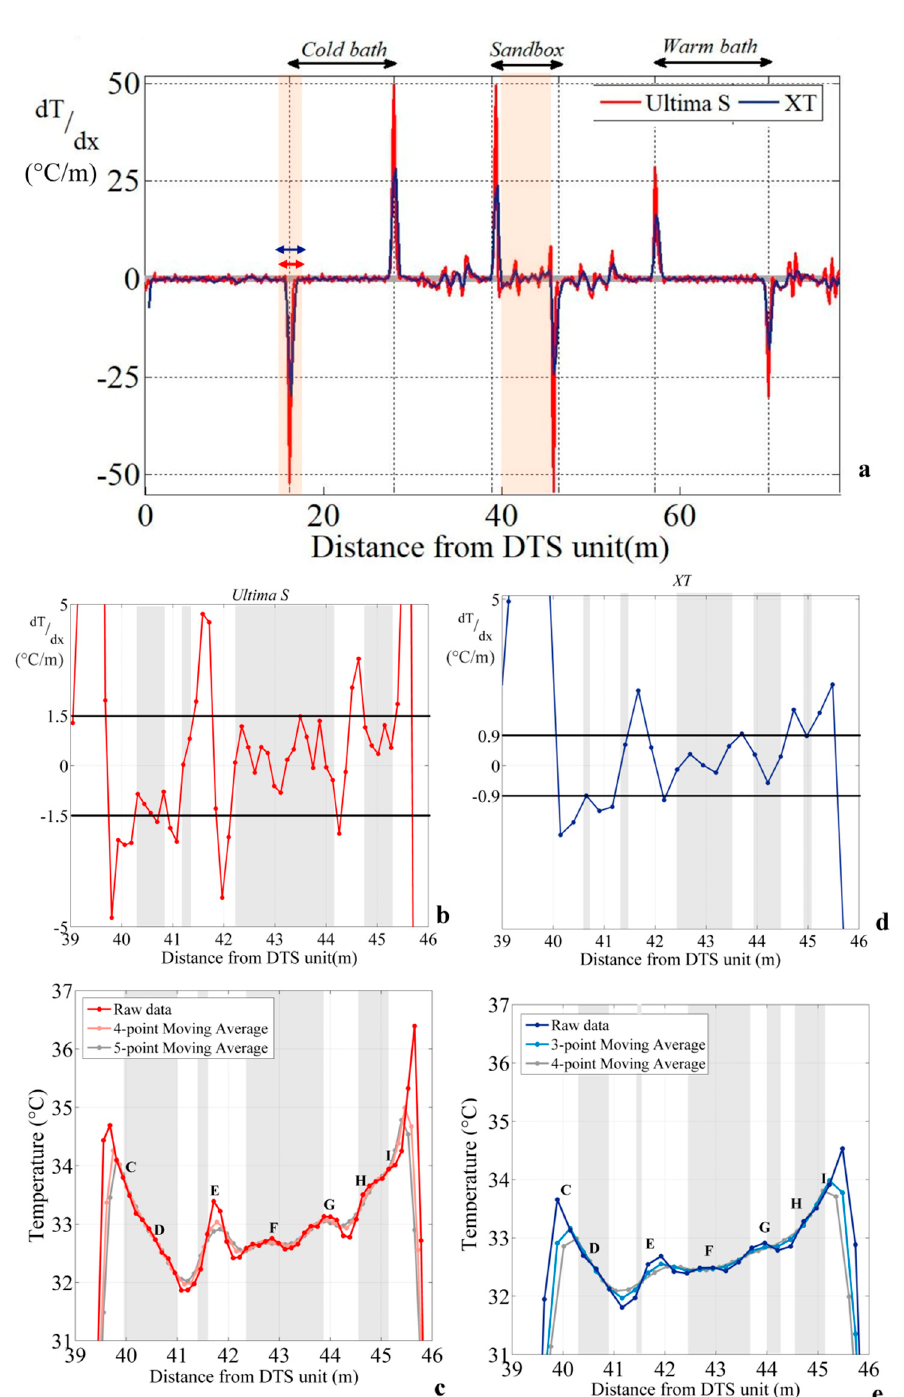
Figure 7. ( a ) Derivative of the temperature with respect to distance. Data were collected during the first heating period, at 02:02:14 p.m. for the Ultima S DTS (Distributed Temperature Sensing) unit and at 02:02:01 p.m. for the XT DTS unit. ( b ) Focus on the derivative of the temperature with respect to distance calculated in the sandbox for the Ultima S DTS unit. Horizontal grey bands represent significant measurement sections defined when the derivative ranges between − 1.5 and 1.5 °C/m. ( c ) Significant measurements points for data collected with the Ultima S DTS unit. ( d ) Focus on the derivative of the temperature with respect to distance calculated in the sandbox for the XT DTS unit. Horizontal grey bands represent significant measurement sections defined when the derivative ranges between − 0.9 and 0.9 °C/m. ( e ) Definition of significant measurements points for data collected with the XT DTS unit.